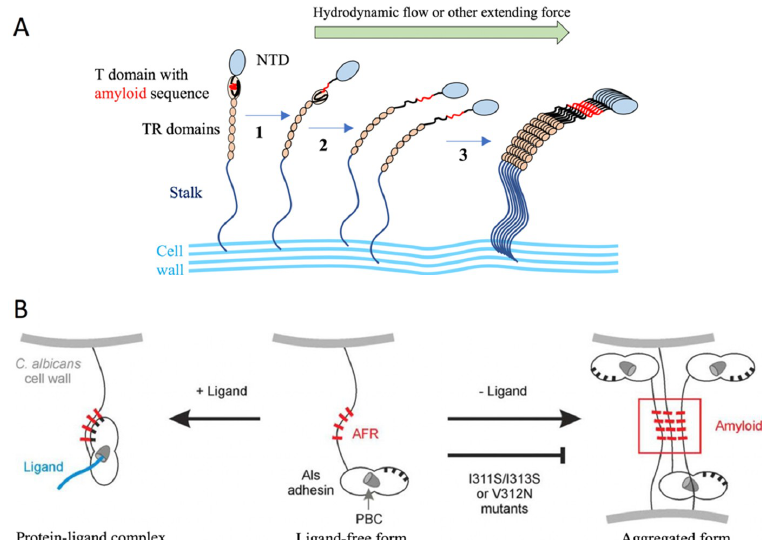
Figure 10. Models proposed that explain the function of the amyloid‐forming region (AFR) in Als protein interactions. A. Force‐induced aggregation of Als proteins on the surface of the same cell. In protein interactions. ( A ) Force-induced aggregation of Als proteins on the surface of the same cell. In the initial state, the amyloid core peptide is buried in the interface between the N‐terminal adhesin domain (NTD) (blue) and the T‐domain. In step 1, shear stress unpacks this interface; in step 2, the T‐ nanodomain (step 3). Adapted from [134]. B. Proposed conformations of the AFR in Als adhesins.